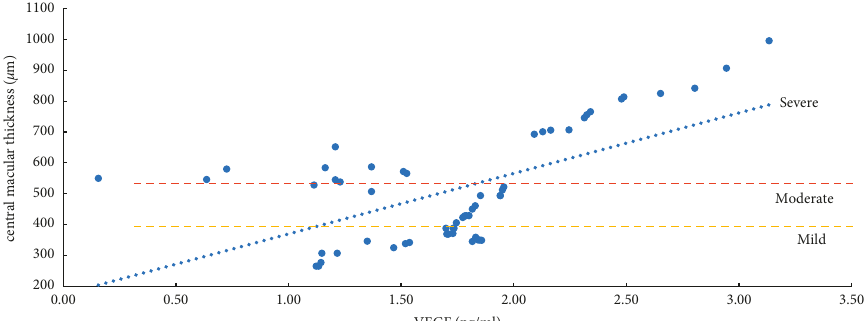
Figure 1: Correlation analysis of ME with a mild, moderate, and severe degree and VEGF (vascular endothelial growth